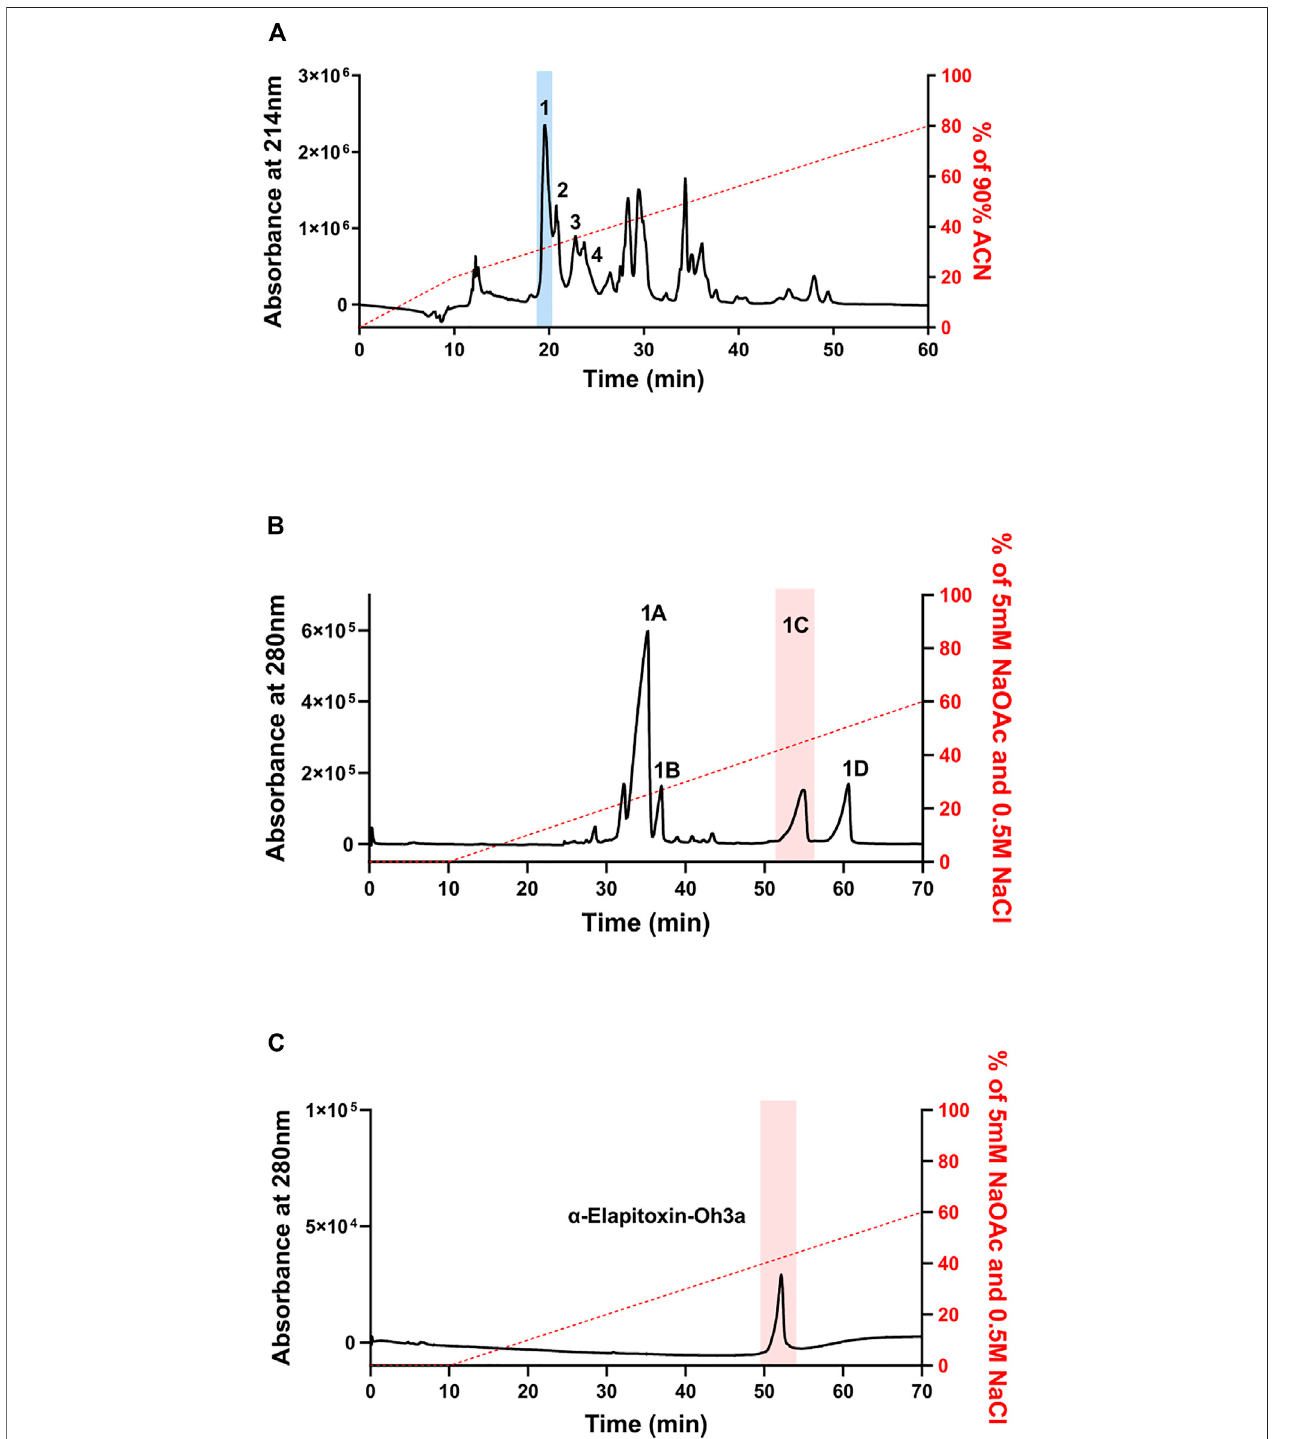
FIGURE 2 | Chromatograms of O. hannah venom showing the fractionation steps to purify α -Elapitoxin-Oh3a. (A) O. hannah venom by reverse-phase HPLC on a JupiterC18semi-preparativecolumn; (B) fractionation ofpeak 1byion-exchangechromatography onaMonoSstrongcation exchangecolumn; (C) furtherpuri fi cation of peak 1C by ion-exchange chromatography on a Mono S strong cation exchange column.